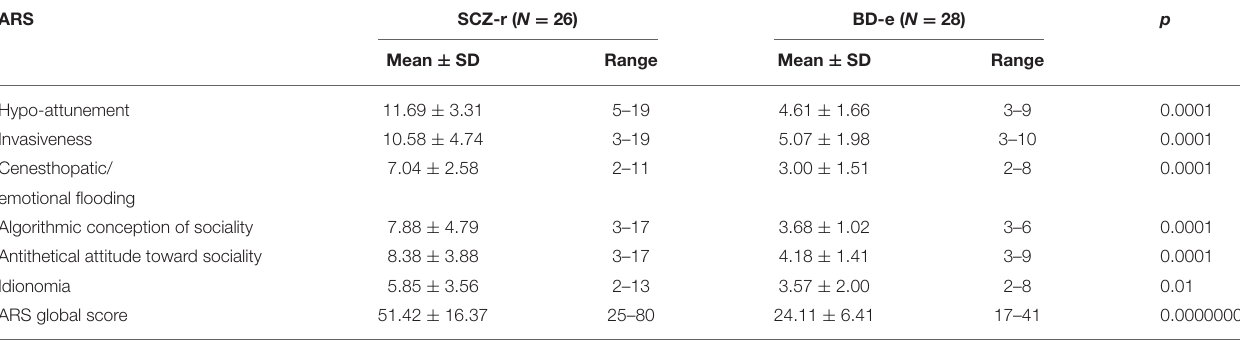
TABLE 5 | Severity of the Autism Rating Scale (ARS) scores in the two patient